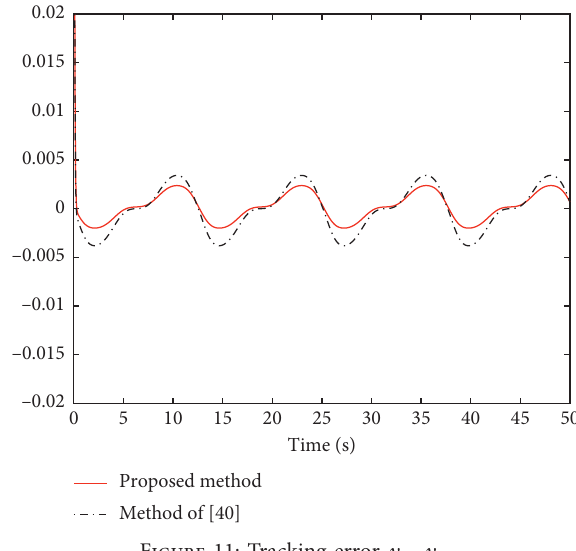
Figure 11: Tracking error y − y